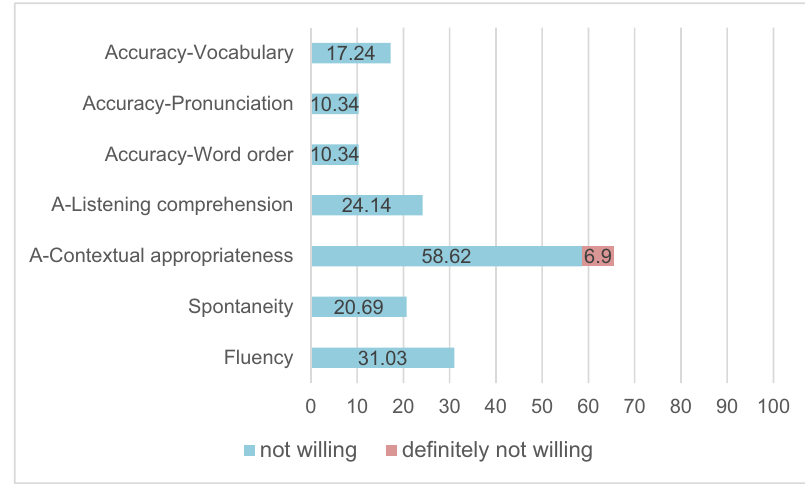
Figure 10: Unwillingness rates under anxiety about L1 Japanese abilities ( % ) .